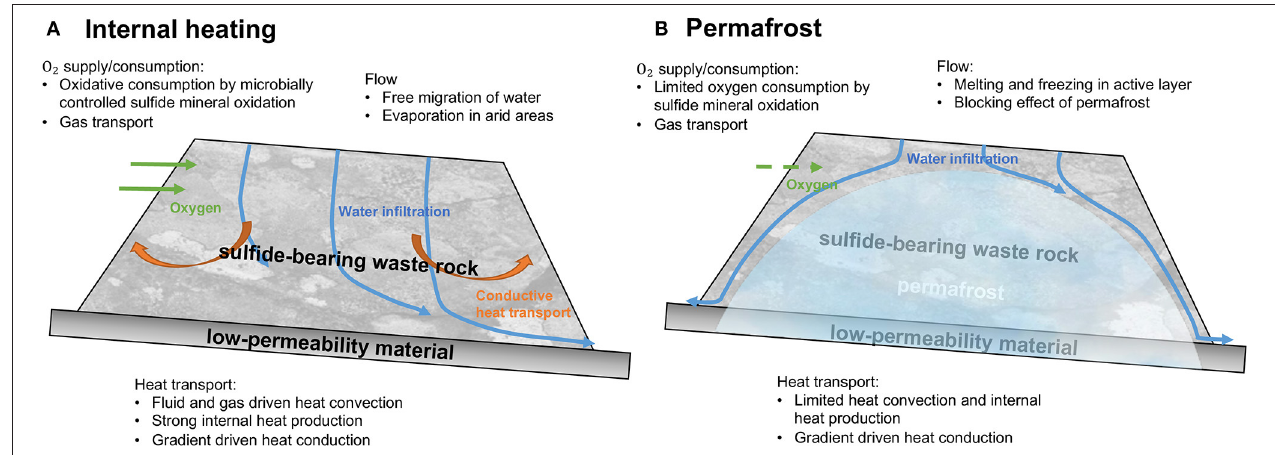
FIGURE 2 | Coupled processes occurring within a waste rock pile for (A) internal heating and (B) permafrost conditions. Modified after Lefebvre et al. (2001) and Amos et al. (2015).